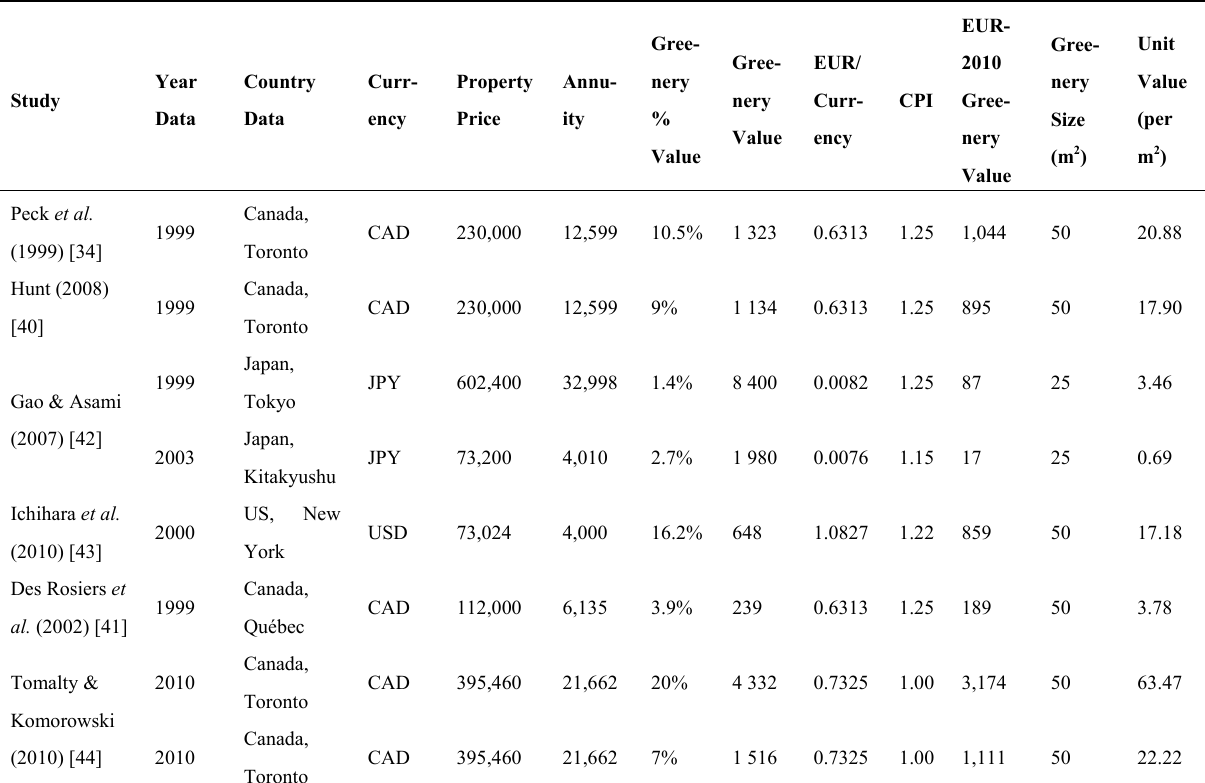
Table 1. Value estimates, per household per year, green roof/wall †